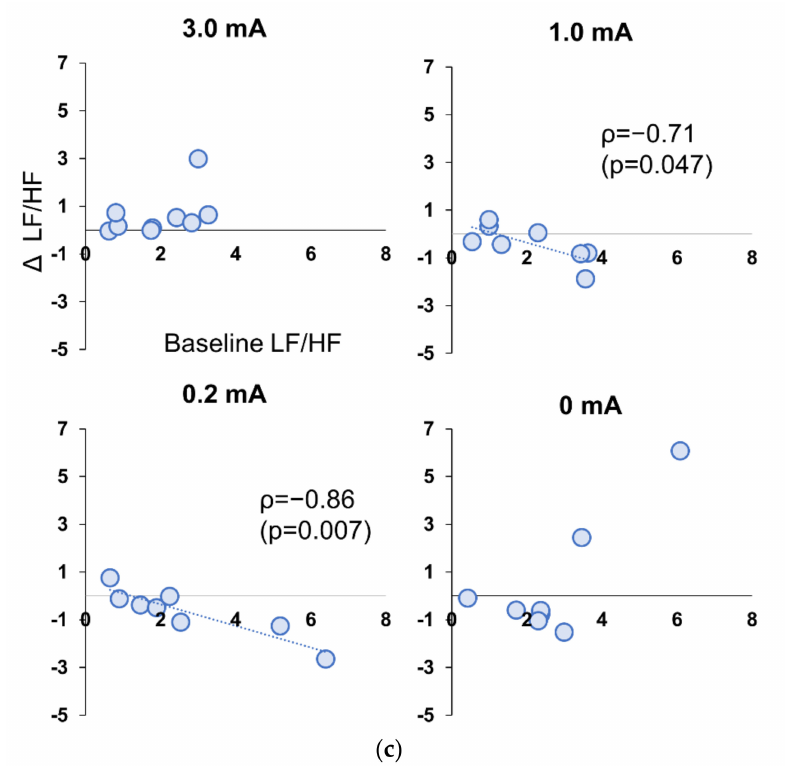
Figure 6. ( a ) Correlation between Baseline LF/HF value and decrement during stimulation period in all participants in Experiment 2. Significant negative correlations were found in the 0.2 mA and 1.0 mA conditions ( p < 0.005). ( b ) Correlation between Baseline LF/HF value and decrement during stimulation period in female participants in Experiment 2. Significant negative correlations were found for all conditions except 0 mA ( p < 0.001). ( c ) Correlation between Baseline LF/HF value and decrement during stimulation period in male participants in Experiment 2. Significant negative correlations were found in the 0.2 mA and 1.0 mA conditions ( p <